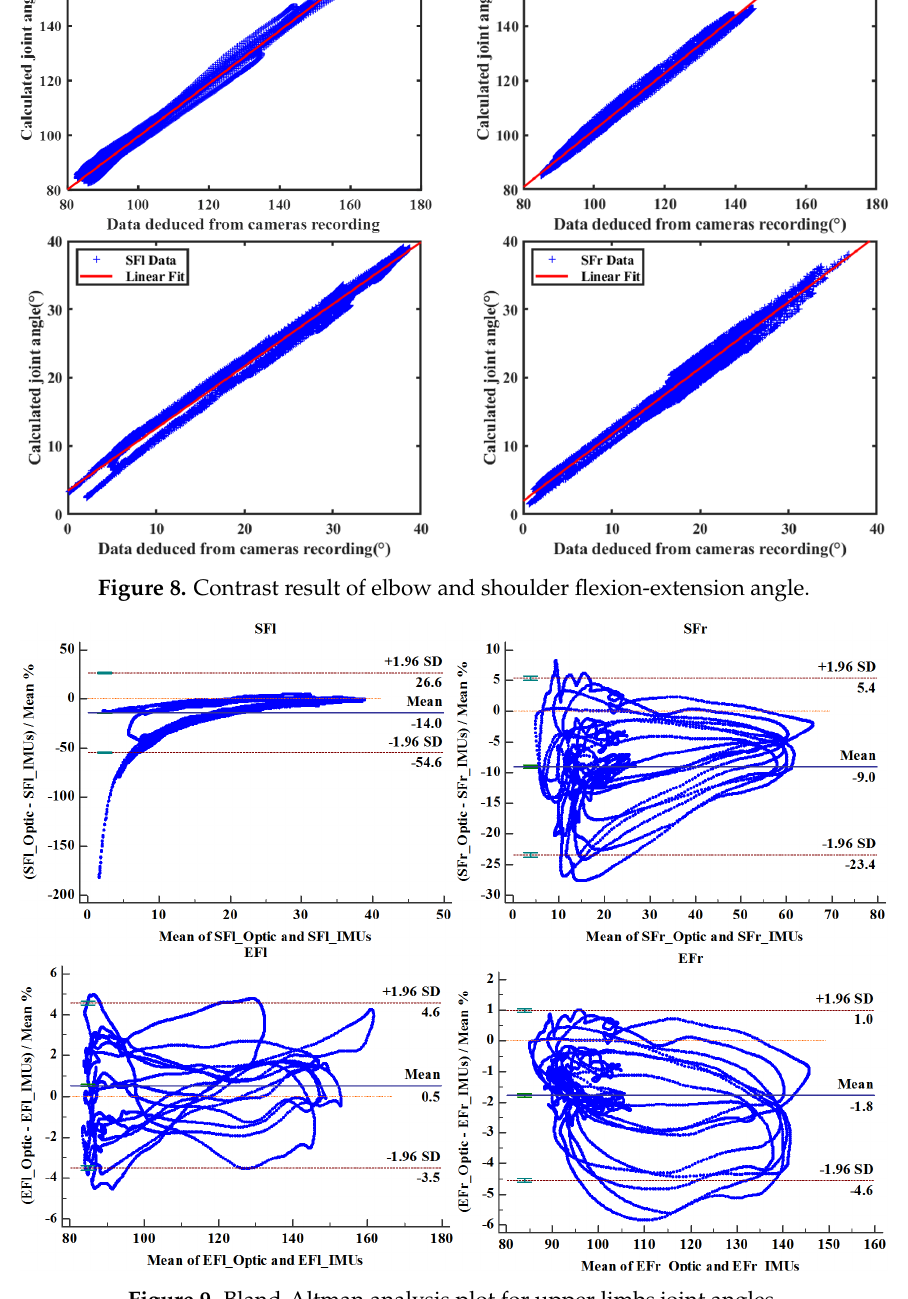
Figure 9. Bland-Altman analysis plot for upper limbs joint angles. Table 2. Joint angle measurement